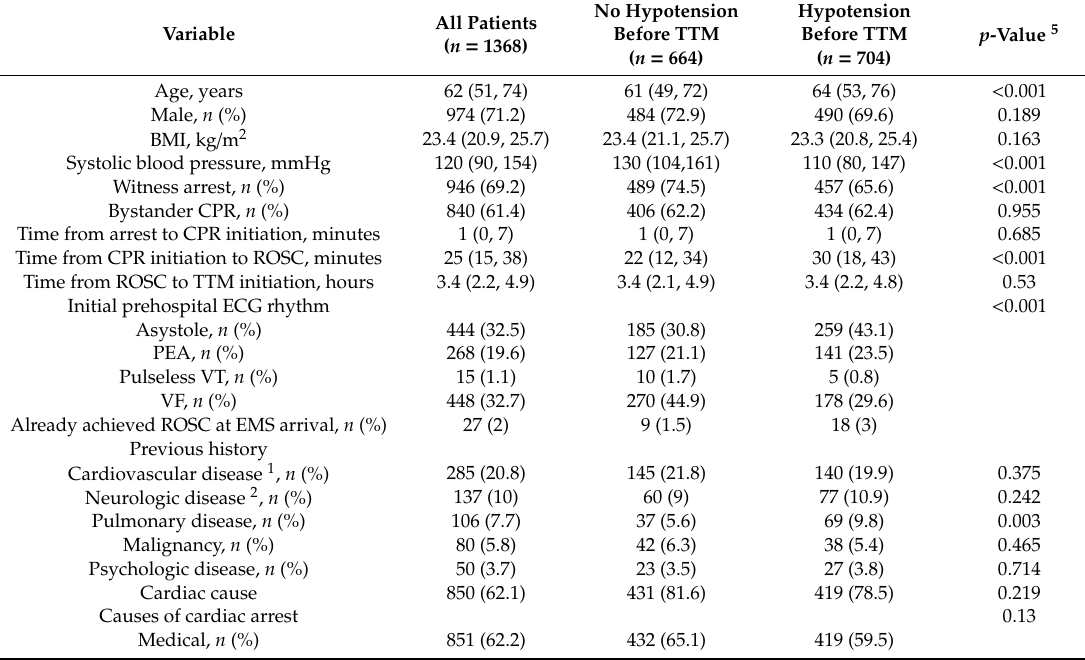
Table 1. Baseline